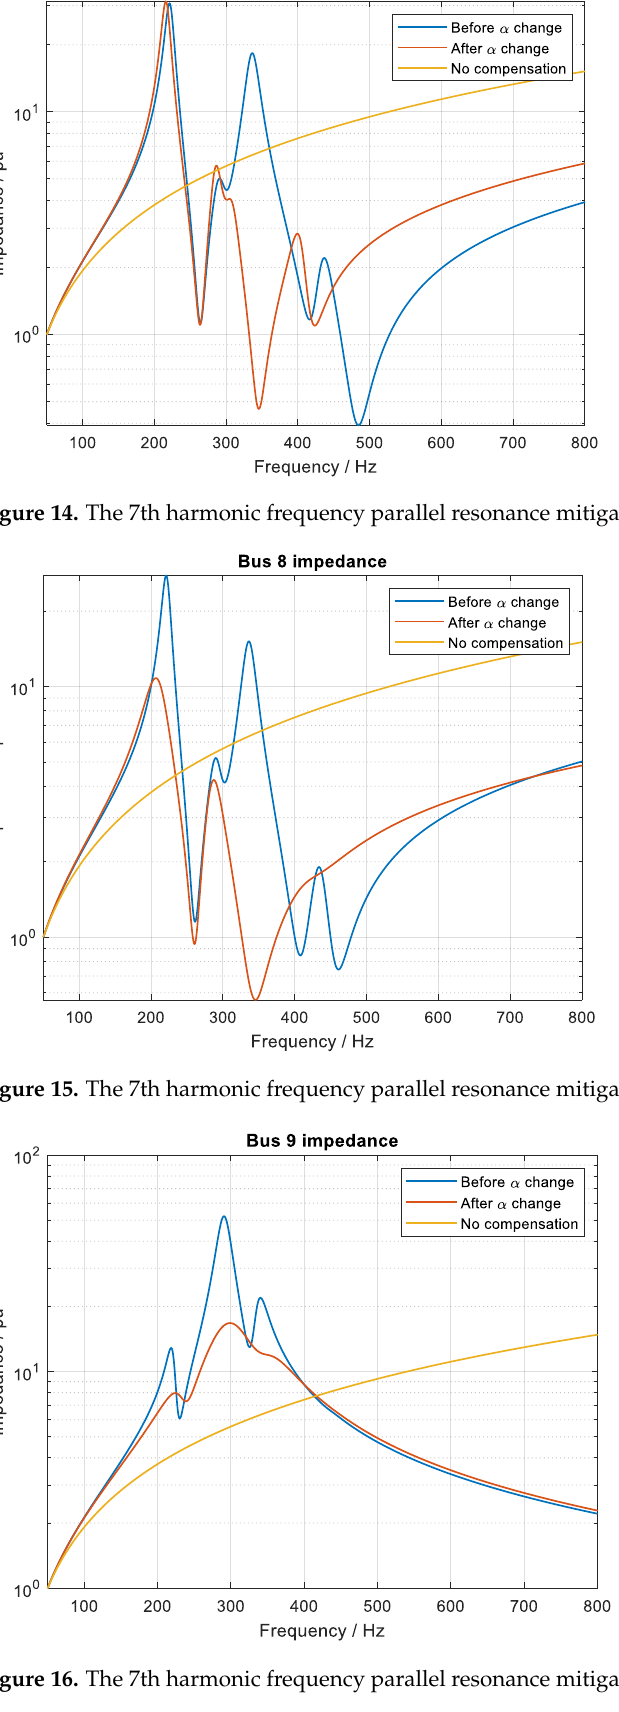
Figure 13. The 7th harmonic frequency parallel resonance mitigation in bus 6.